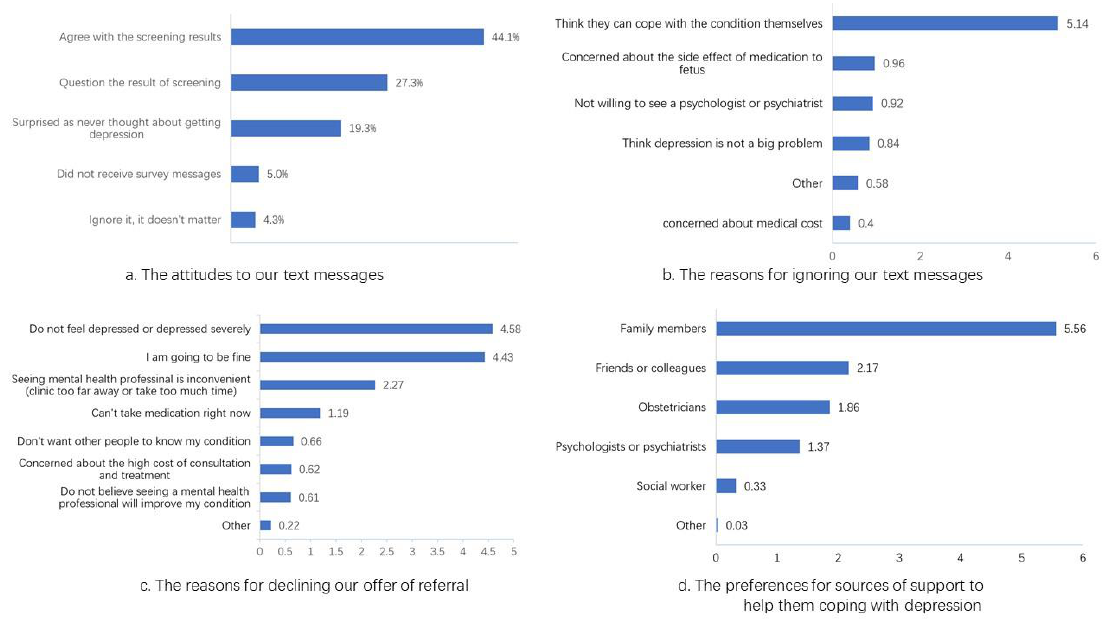
Figure 2. The responses of screen-positive women using ranking scores to indicate the importance of the items among our survey respondents.